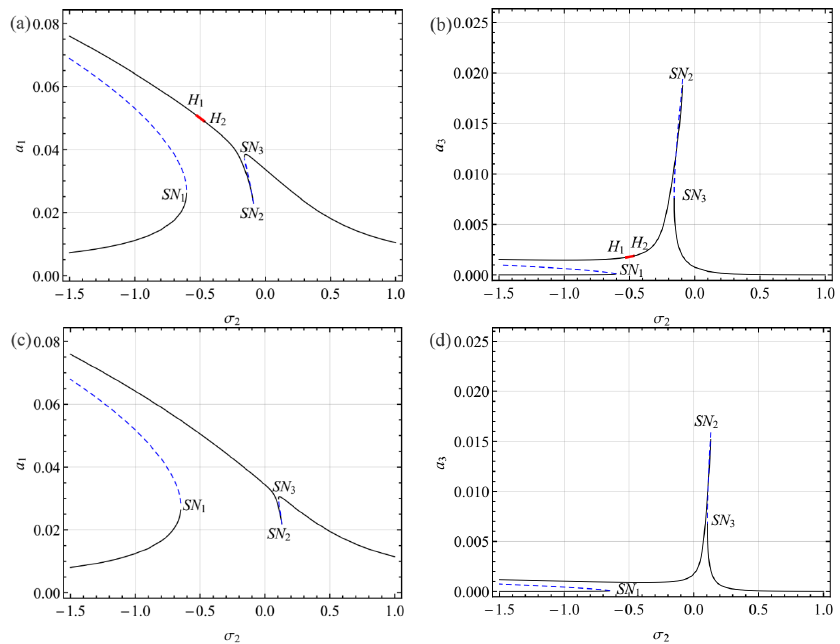
Figure 5. Frequency response curves for the first and third modes: ( a , b ) V DC = 28.00, σ 1 = 0.005; ( c , d ) V DC = 30.80, σ 1 = 0.6307.